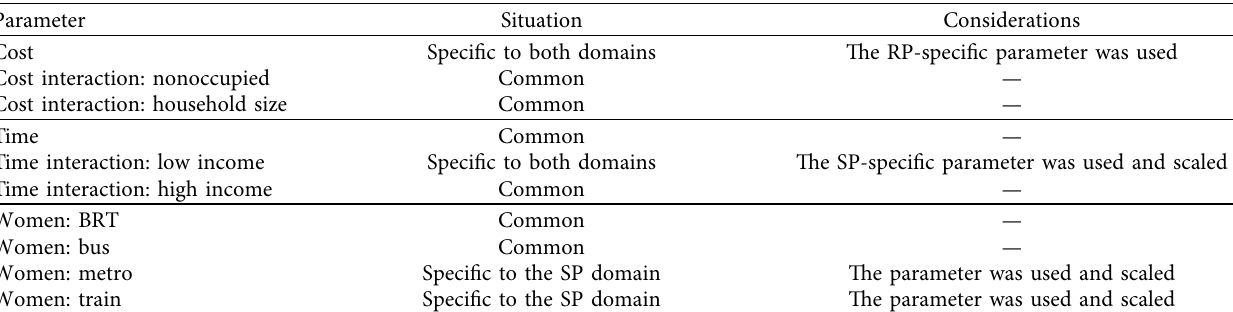
Table 7: Parameter selection for